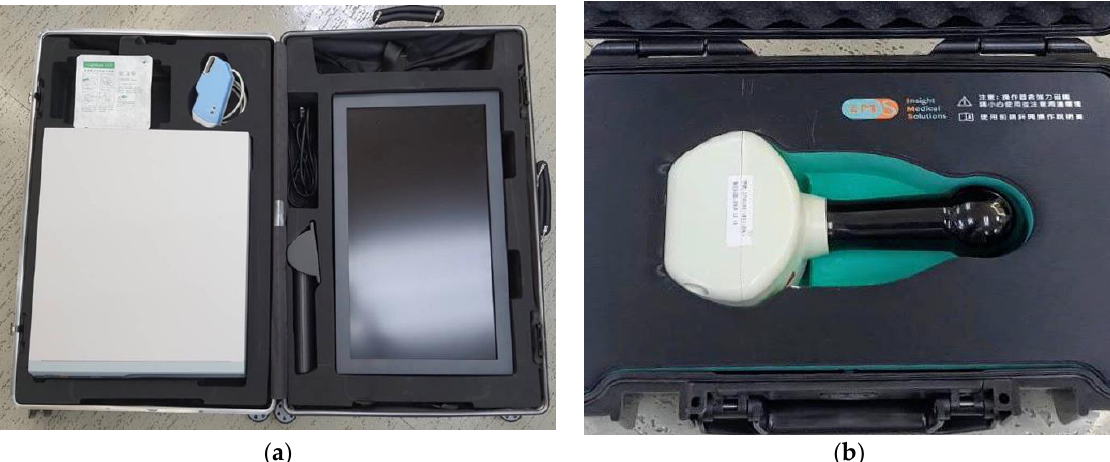
Figure 1. ( a ) Image processor, LCD monitor and InsightEyes EGD, packed in a roller suitcase. ( b ) Hand-held magnetic field navigator.